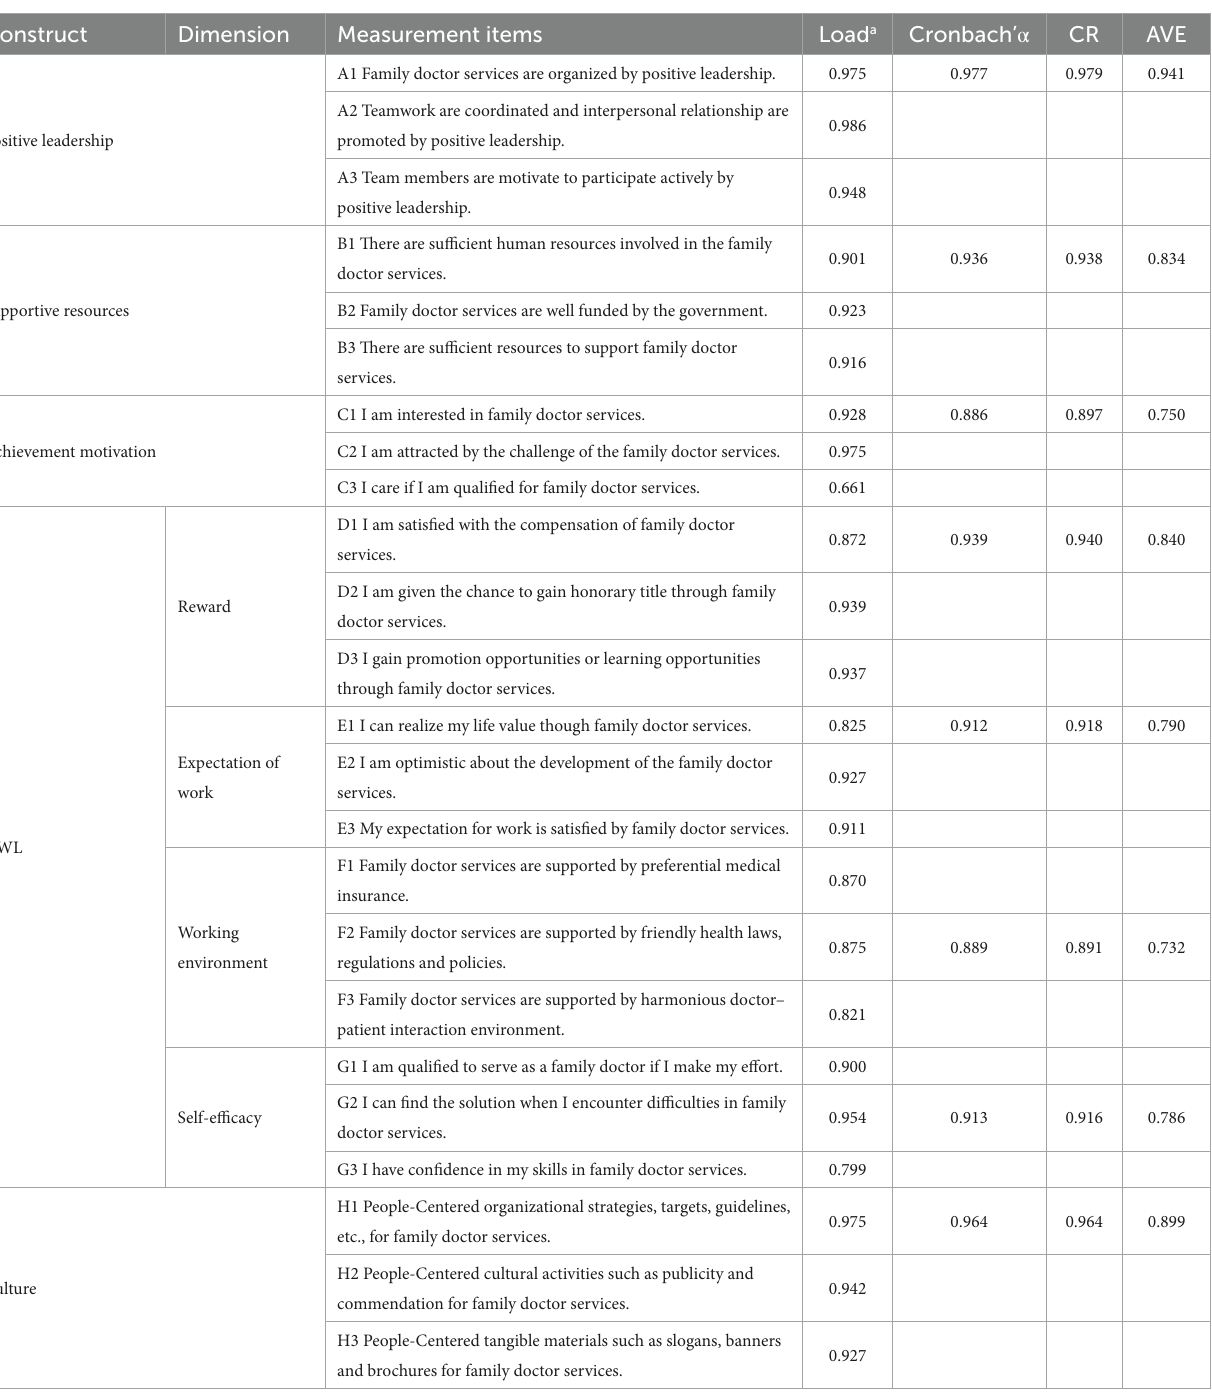
TABLE 1 Measurement items and results of reliability and validity analysis of the questionnaire ( N = 473). Construct Dimension Measurement items Load a Cronbach’ α